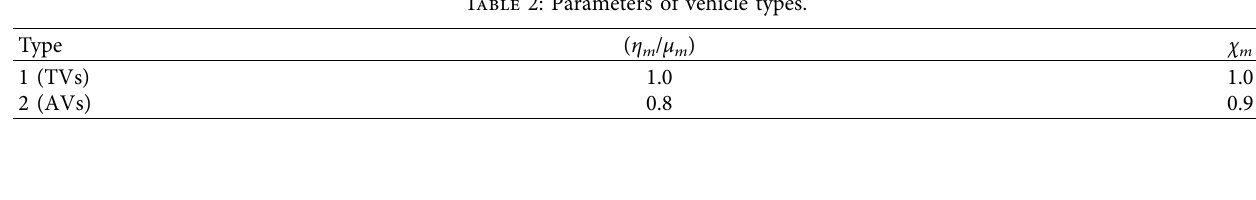
Table 3: Bifurcation demand flow, reference scenario θ